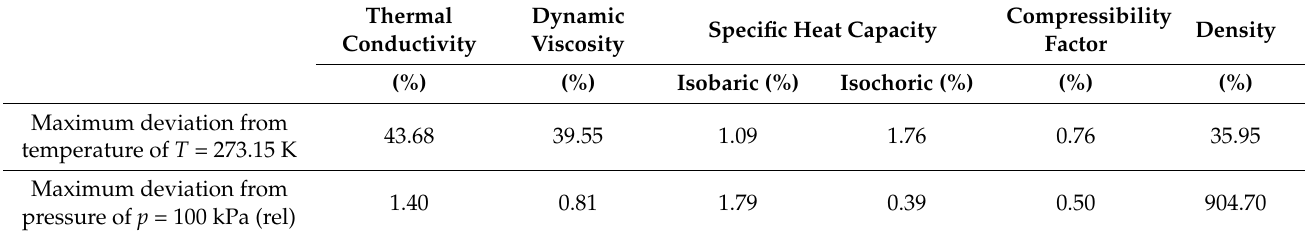
Compressibility Density Factor